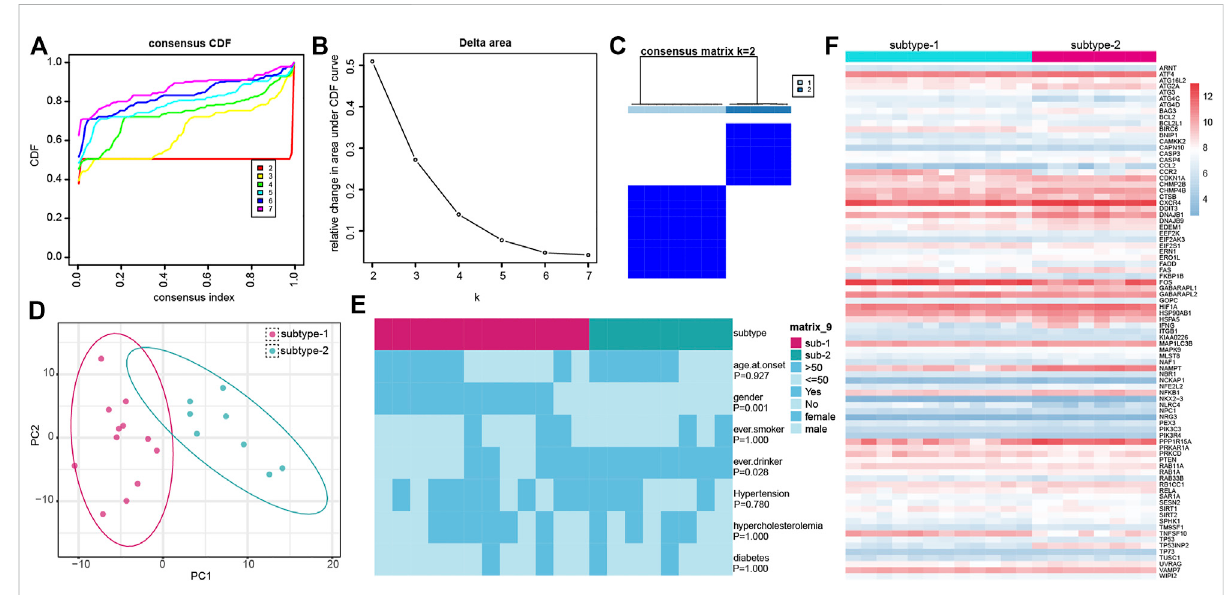
FIGURE 5 Identi fi cation of different autophagy gene expression patterns by unsupervised consensus clustering. (A) Consensus clustering cumulative distribution function (CDF) for k = 2 – 7. (B) Relative change in area under the CDF curve for k = 2 – 7. (C) Heatmap of the matrix of co-occurrence proportions for IS samples. (D) PCA analysis for the transcriptome pro fi les of the two distinct autophagy subtypes. (E) Comparison of clinical characteristics between the two subtypes. (F) Expression status of subtype-speci fi c autophagy genes in the two